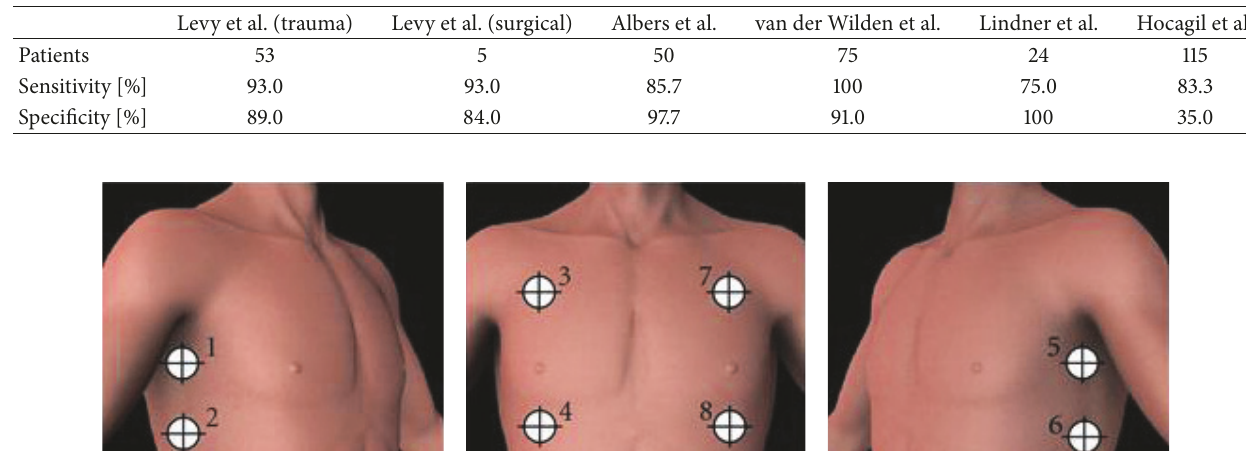
Table 1: Sensitivity and specificity of PneumoScan in previous studies.